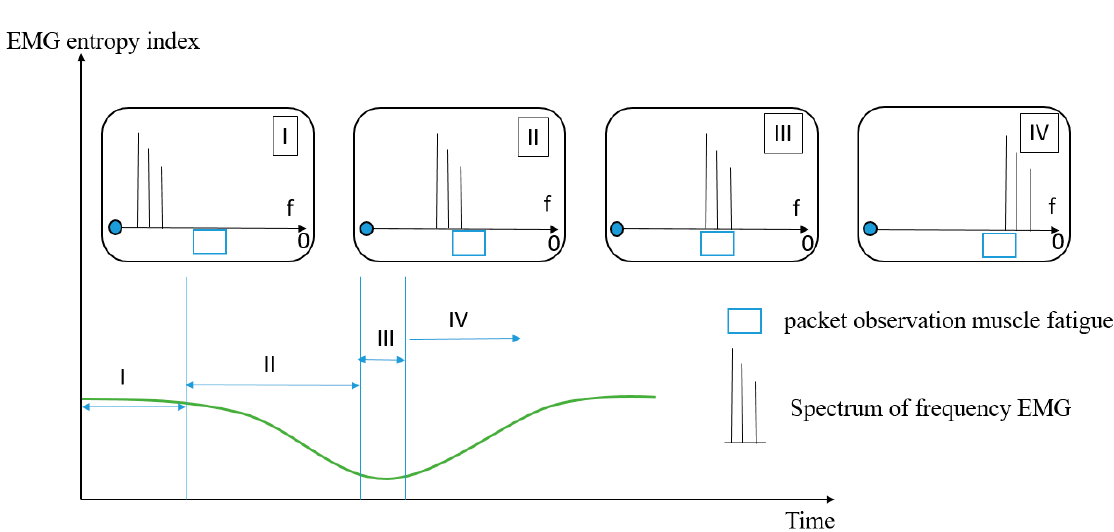
Figure 10. The relationship between spectrum of frequency and EMG entropy index.